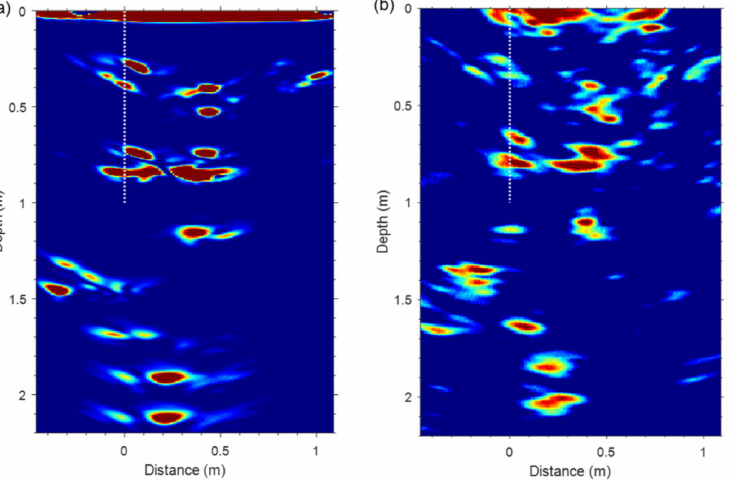
Figure 9. ( a ) Imaging result of the FDTD simulation data. ( b ) Geometric mean of four lunar measure- ments illustrated in Figure 5. The positions and extent of strong radar echoes in the FDTD model are very similar to that in the lunar data, indicating that our inference of the subsurface structure of regolith at drilling site is